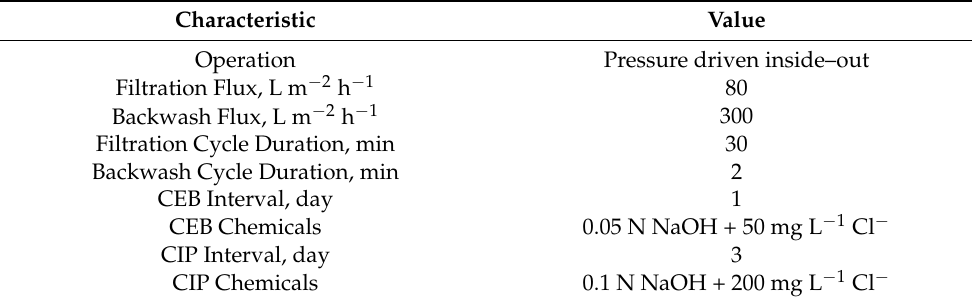
Table 1. Summary of Multi–day Testing